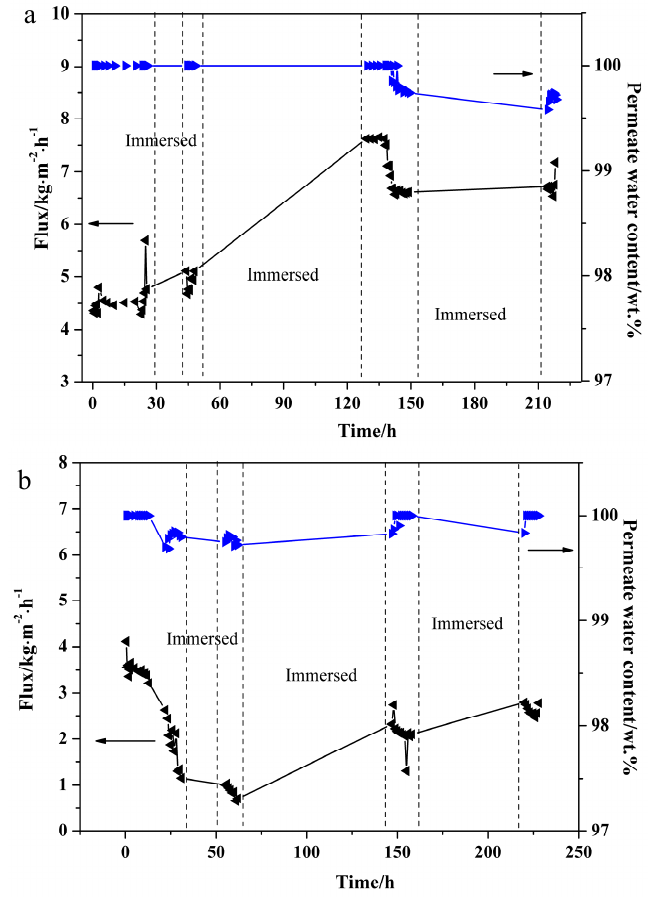
Figure 8. PV dehydration of 90 wt % ethanol/water mixture with different cation-treated NaA zeolite membranes ( a ) KCl solution treatment, ( b ) AgNO 3 solution treatment.